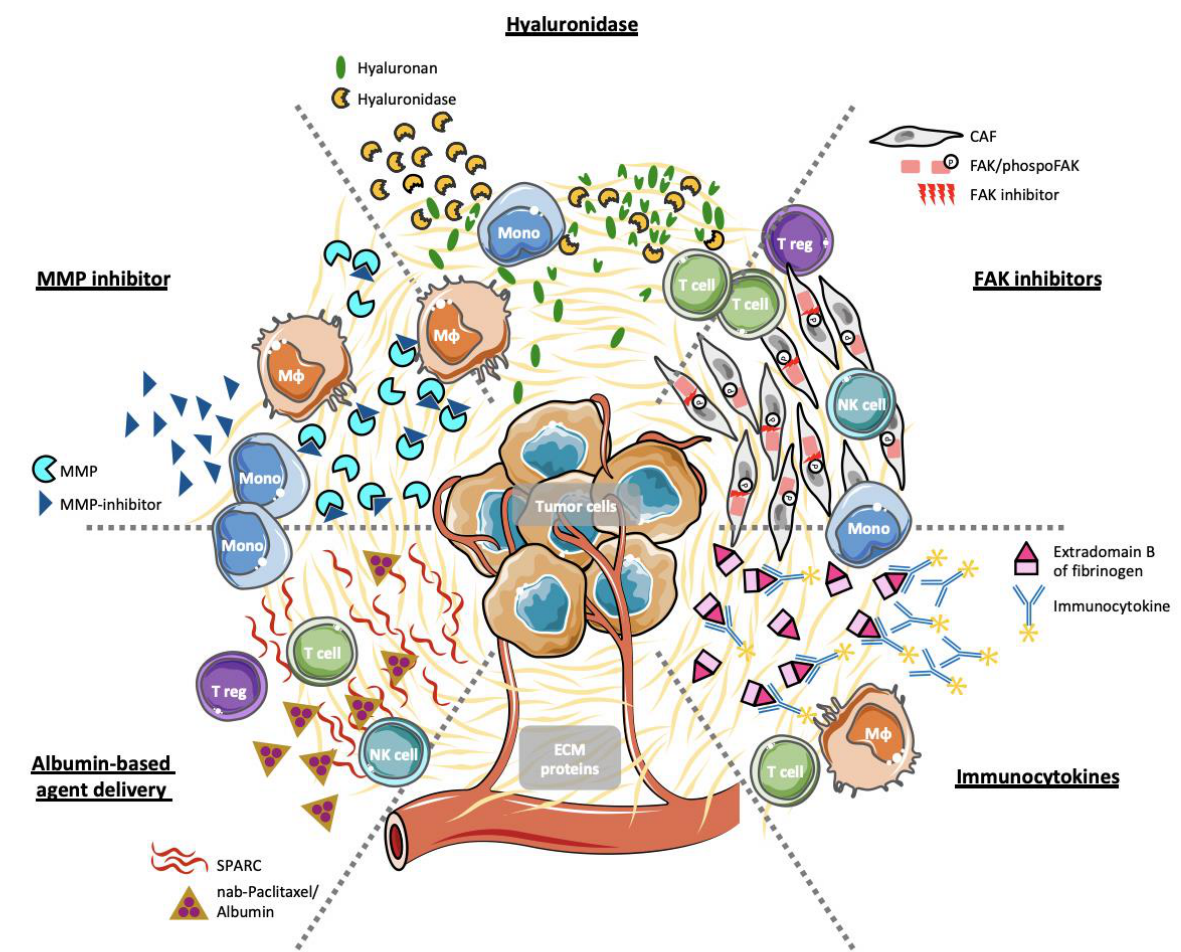
Figure 1. Therapeutic approaches targeting ECM proteins. ECM proteins within the TME have been selectively targeted by different approaches: Albumin-bound nab-Paclitaxel was shown to bind to SPARC-rich TMEs; MMP-inhibitors prevent the dissemination of basement membranes and vascular structures resulting in reduced tumor cell invasion; Hyaluronidases depolymerize HA and have suggested to make the TME permissive for immune cell infiltration and drug delivery; Prevention of FAK-phosphorylation prevents FAK activation resulting in increased sensitivity to chemotherapy and immunotherapy; Detection of the extradomain B of fibrinogen by immunocytokines has been proposed to facilitate specific antibody delivery of cytokines such as IL-2. (The displayed figure was partially generated with elements obtained from Servier Medical Art